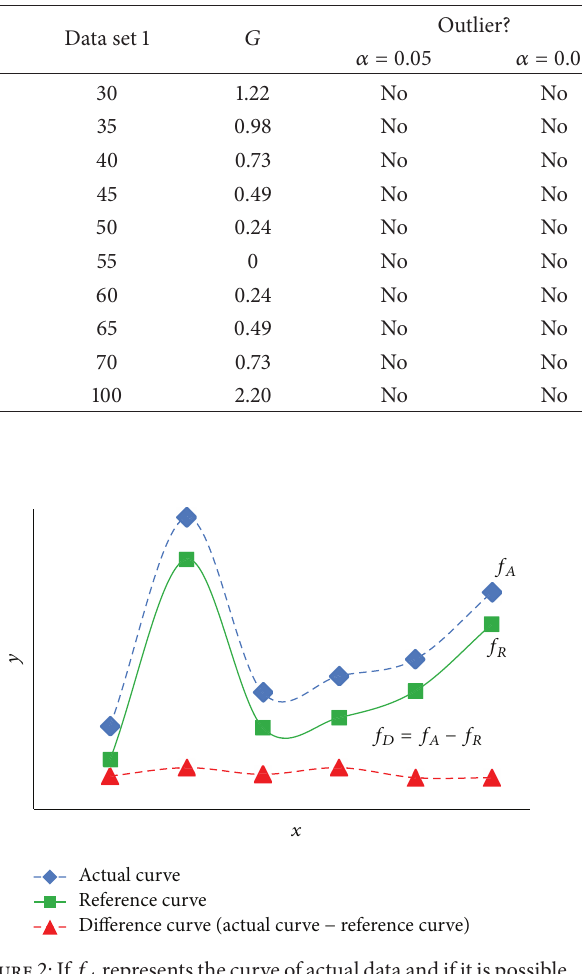
Figure 3: For an outlier, difference curve ( 𝑓 𝐷 ) shows significant deviation in relation to the